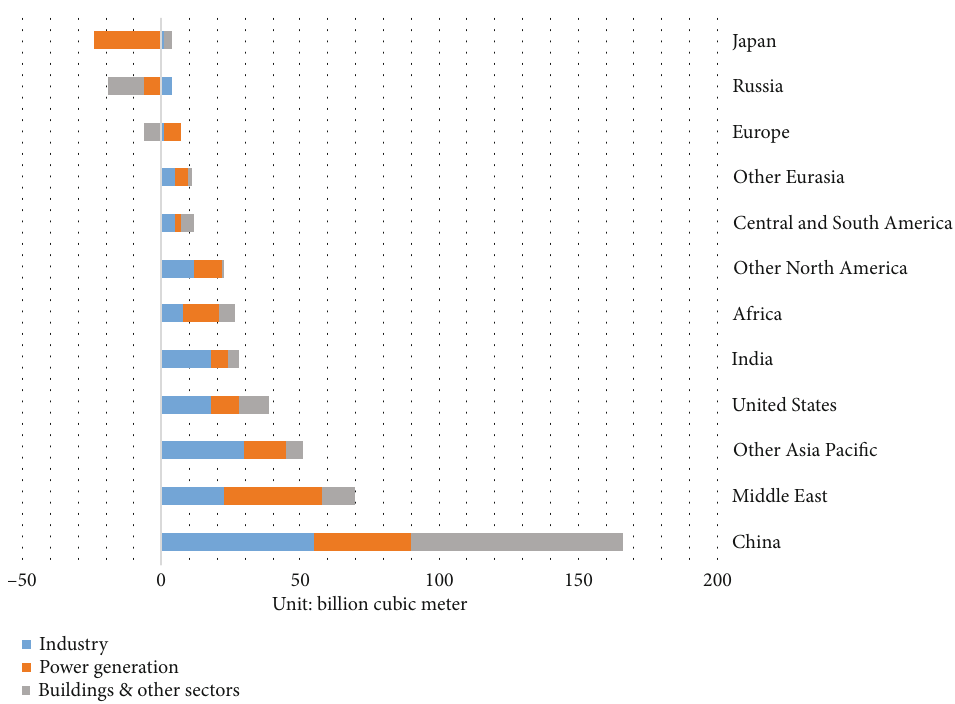
Figure 1: World natural gas consumption growth for selected countries and regions, 2018-2024.